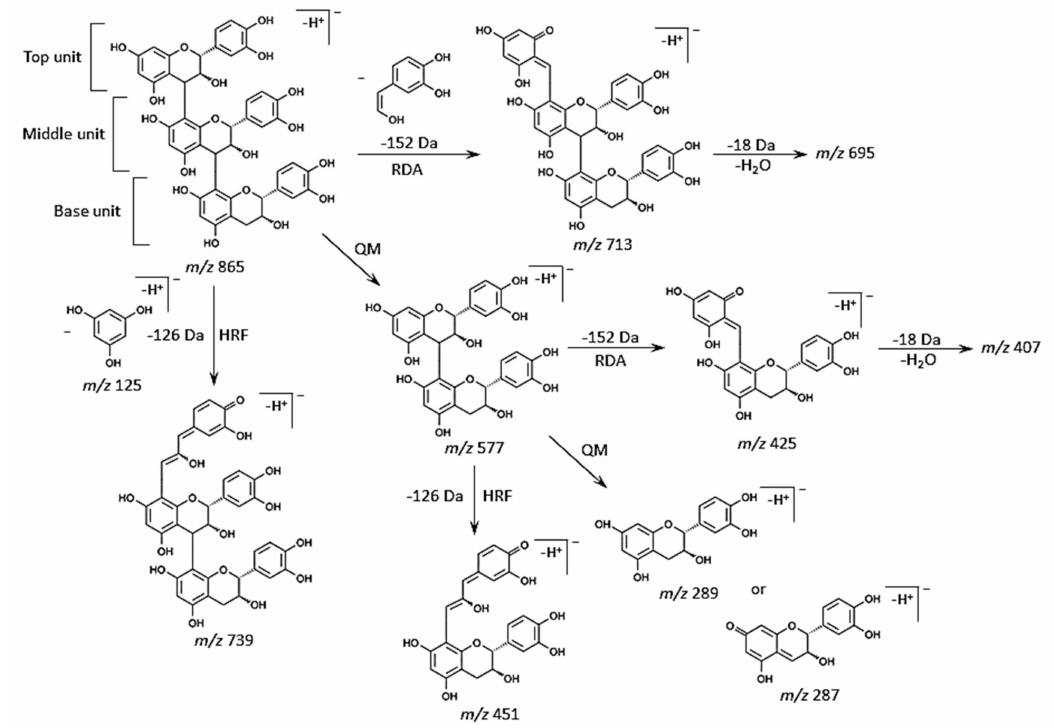
Figure 4. Typical fragmentation patterns of procyanidins by retro-Diels-Alder (RDA), heterocyclic ring fission (HRF), and quinone methide (QM) reactions. Typical fragmentation patterns of B-type procyanidin trimer, (epi)catechin-(epi)catechin-(epi)catechin [M − H] − ion at m / z